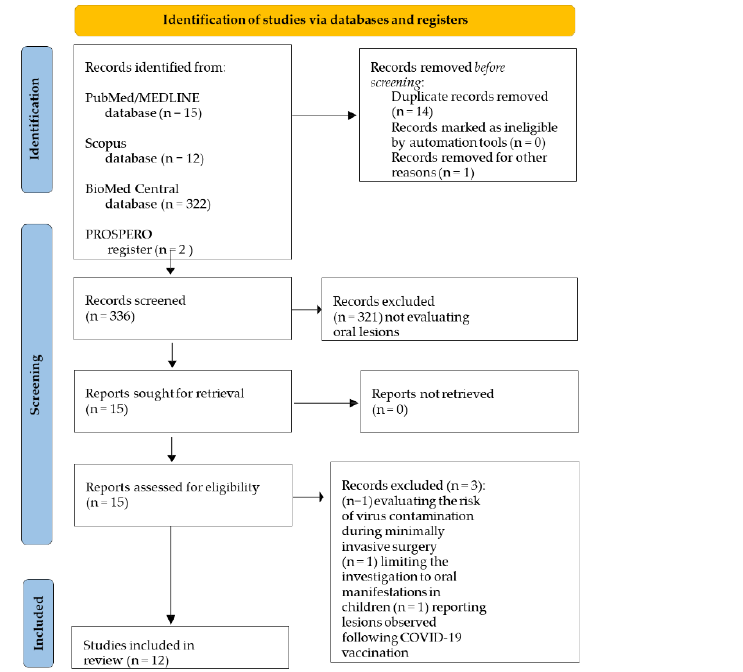
Figure 1. PRISMA flow chart.